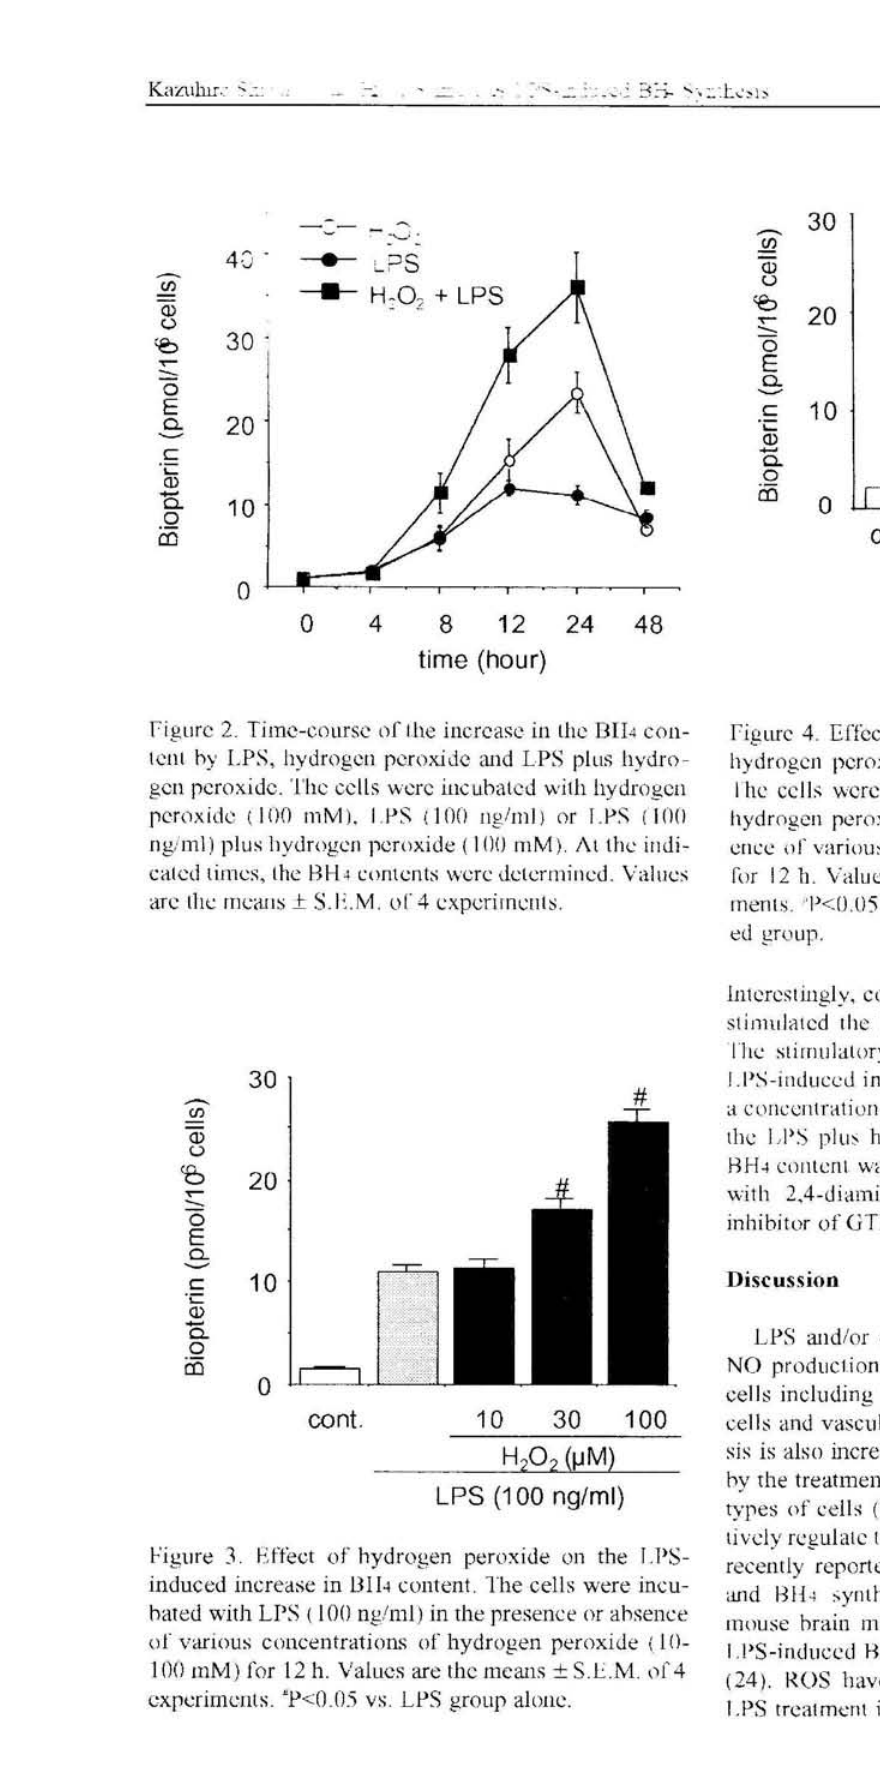
Figure 3. Effect of hydrogen peroxide on the 1.PS- induced increase in ÜII4 content. The cells were incu- bated with LPS ( 100 ng/ml) in the presence or absence of various concentrations of hydrogen peroxide (ΙΟ- Ι 00 mM) for 12 h. Values are the means ± S.L.M. of 4 experiments. *P<0.05 vs. LPS group